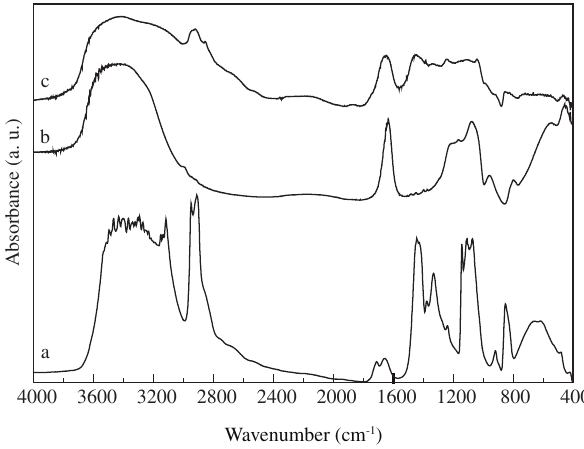
Figure 2. FTIR spectra of samples: a) polyvinyl alcohol, fully hydrolyzed, Celvol 103; b) bioglass; c) hybrid 70 wt. (%) PVA-30 wt. (%) Bioglass (3B-7Pc).